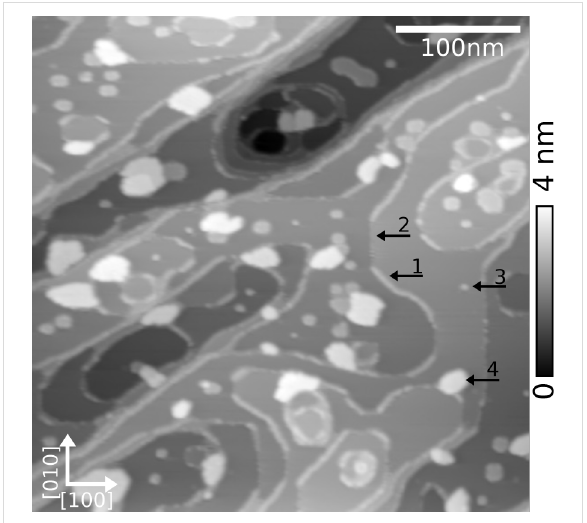
Figure 4: Topography image (400 × 400 nm 2 ) of diporphyrins on KBr(001) after 1 h of annealing at 350 K. Different areas: covered (1) and non-covered (2) step edges, small aggregates (3), and molecular islands (4). Parameters: A = 4 nm, Δ f = − 10